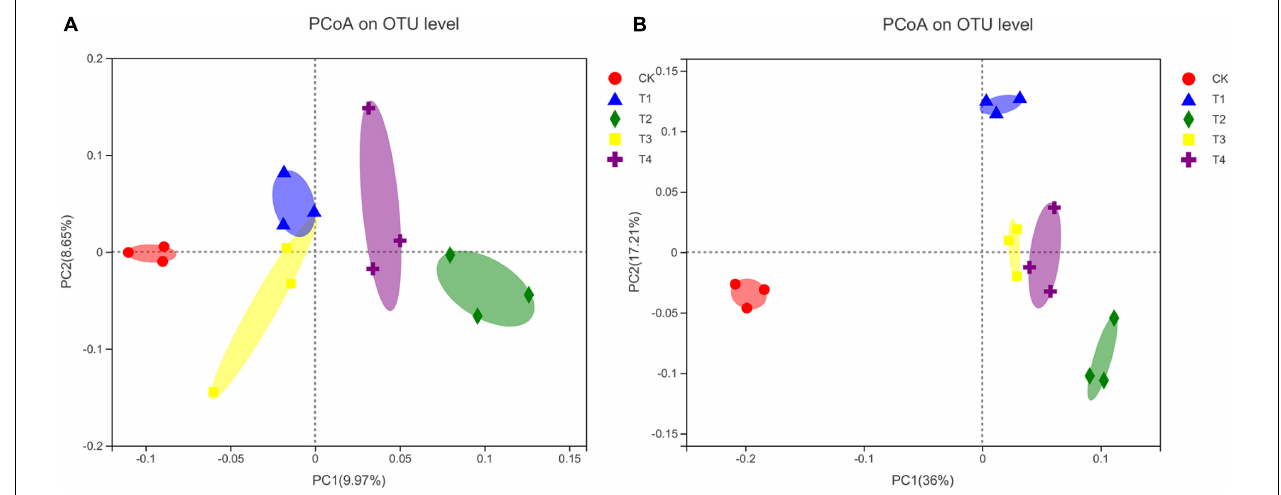
FIGURE 1 | Principal coordinate analysis (PCoA) plots of bacterial (A) and fungal (B) community composition at the OTU level. CK, chemical fertilizer with conventional fertilization rate; T1, chemical fertilizer reduction by 30% + 6,000 kg ha − 1 bio-organic fertilizer; T2, chemical fertilizer reduction by 30% + 9,000 kg ha − 1 bio-organic fertilizer; T3, chemical fertilizer reduction by 40% + 6,000 kg ha − 1 bio-organic fertilizer; T4, chemical fertilizer reduction by 40% + 9,000 kg ha − 1 bio-organic fertilizer.